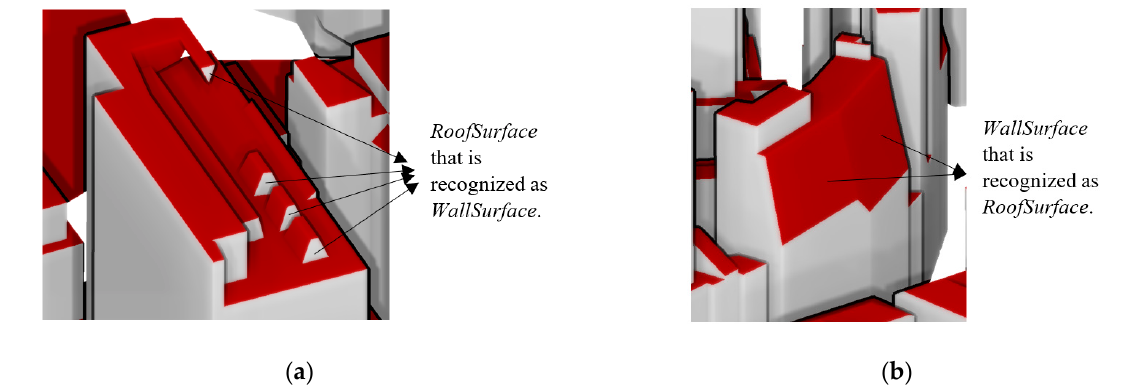
Figure 22. Misclassifications between WallSurface and RoofSurface . ( a ) RoofSurface misclassified as WallSurface , and ( b ) WallSurface misclassified as RoofSurface .